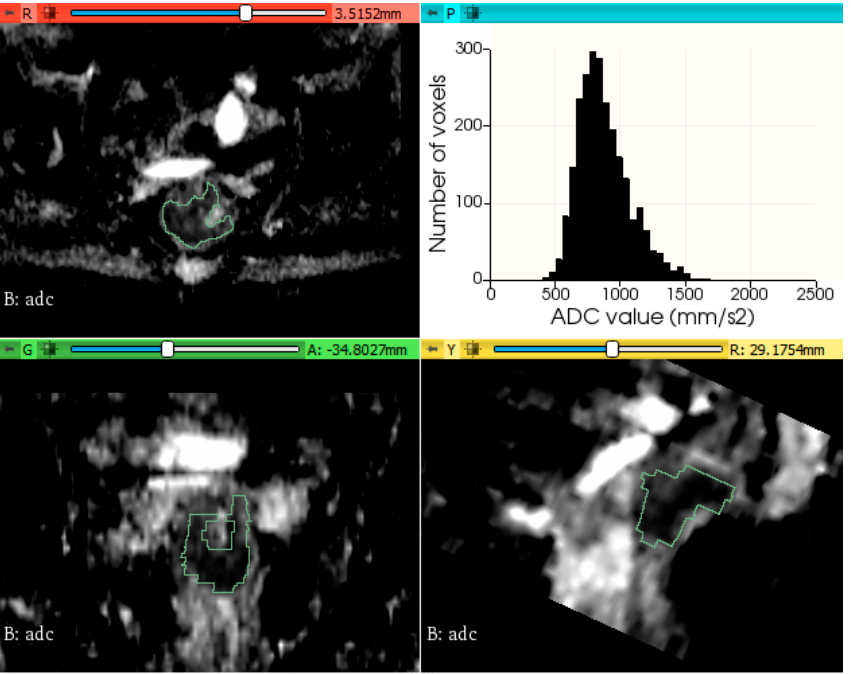
Figure 2 . Example of rectal tumor VOI segmentation on ADC map and histogram plot of the ADC values from a patient without metachronous metastases.